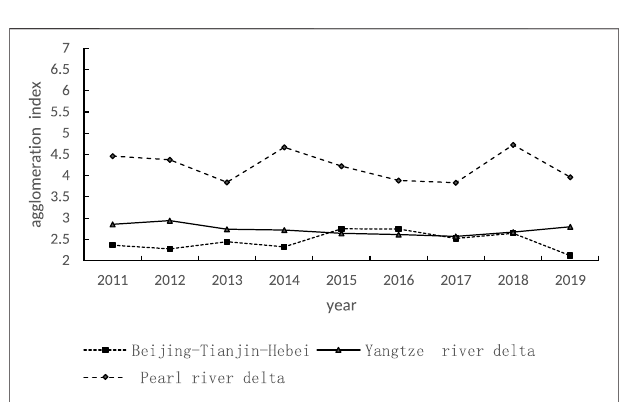
FIGURE 4 | Collaborative agglomeration of two industries.